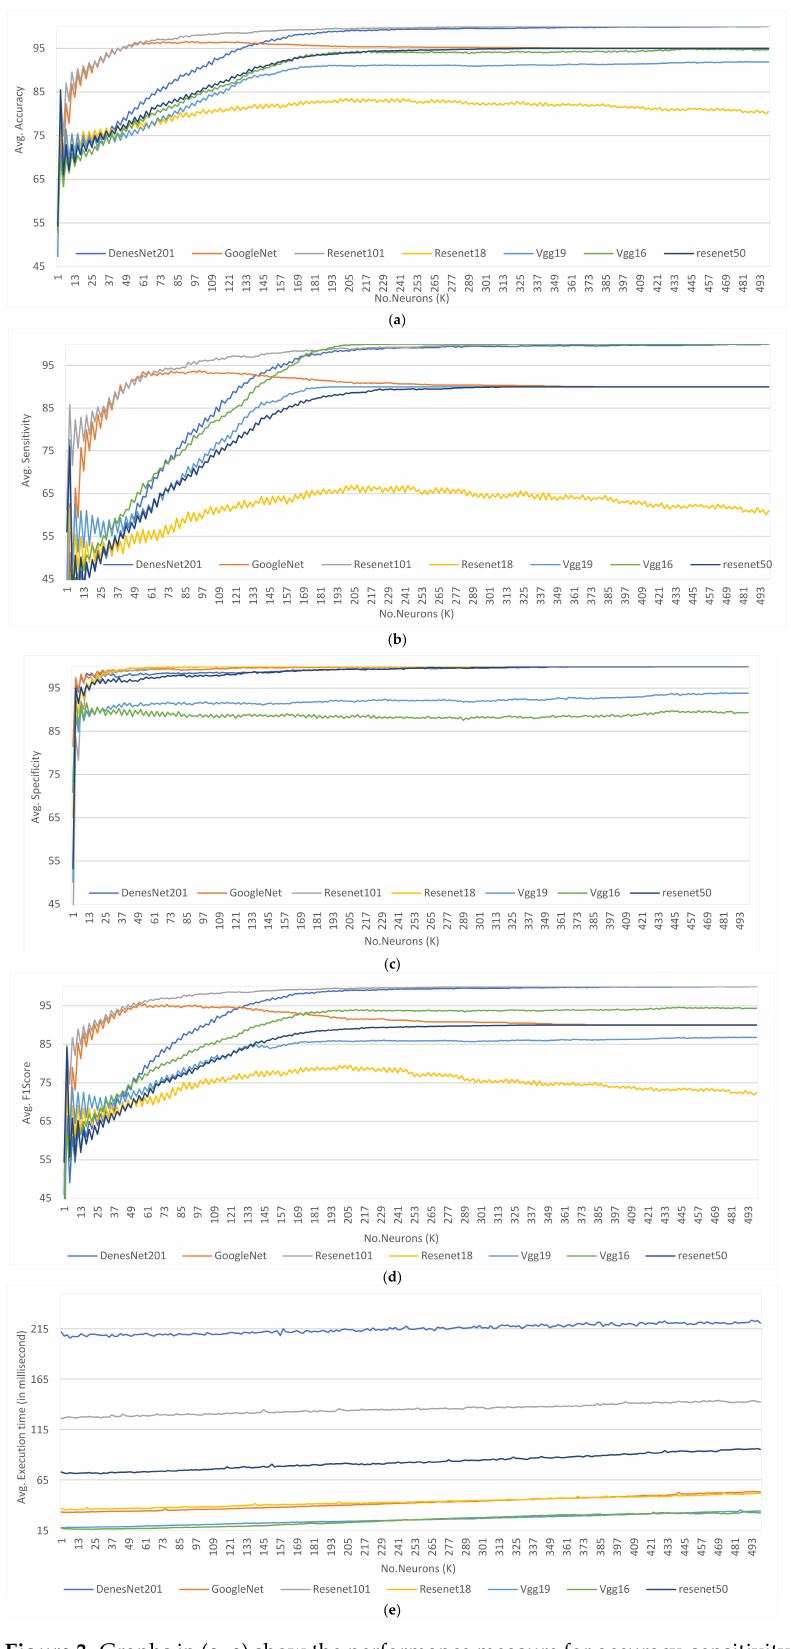
Figure 3. Graphs in ( a – e ) show the performance measure for accuracy, sensitivity, specificity, F1-Score and the testing execution time per image, respectively, for different CNN models with different K